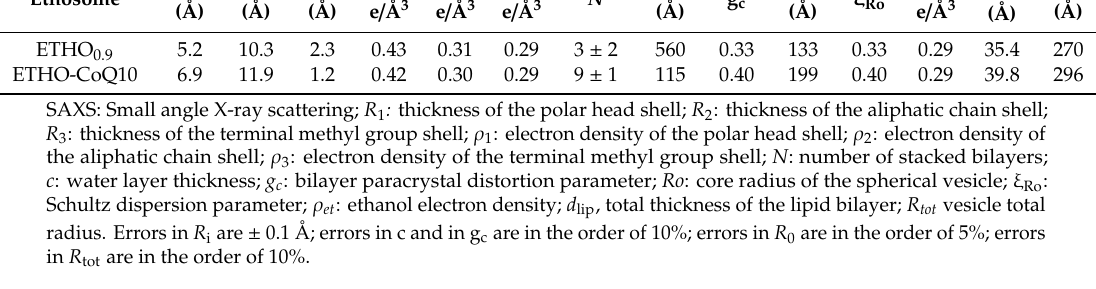
Table 3. Fitting parameters for ethosomes, as determined by SAXS model analysis Ethosome